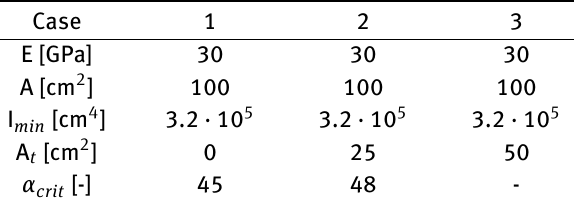
100 kN applied on the top node. The Young’s Modulus of all the bars has been set equal to 30 GPa.